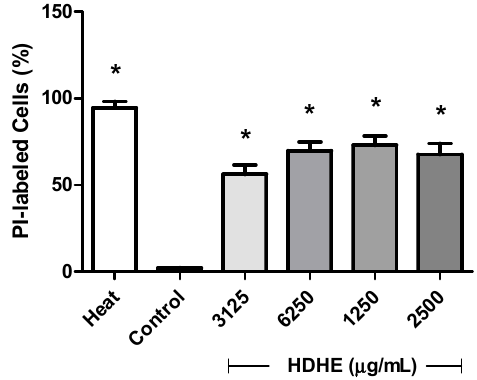
Figure 3. Effect of hydroalcoholic extract from leaves of Himatanthus drasticus on Klebsiella. pneumoniae membrane. Membrane disruption was assessed by Propidium Iodide (PI) incorporation indicating. HDHE: H. drasticus hydroalcoholic extract. * p < 0.05 in relation to untreated cells. The experiment we performed in two independent assays and at least 20,000 cells were analyzed.